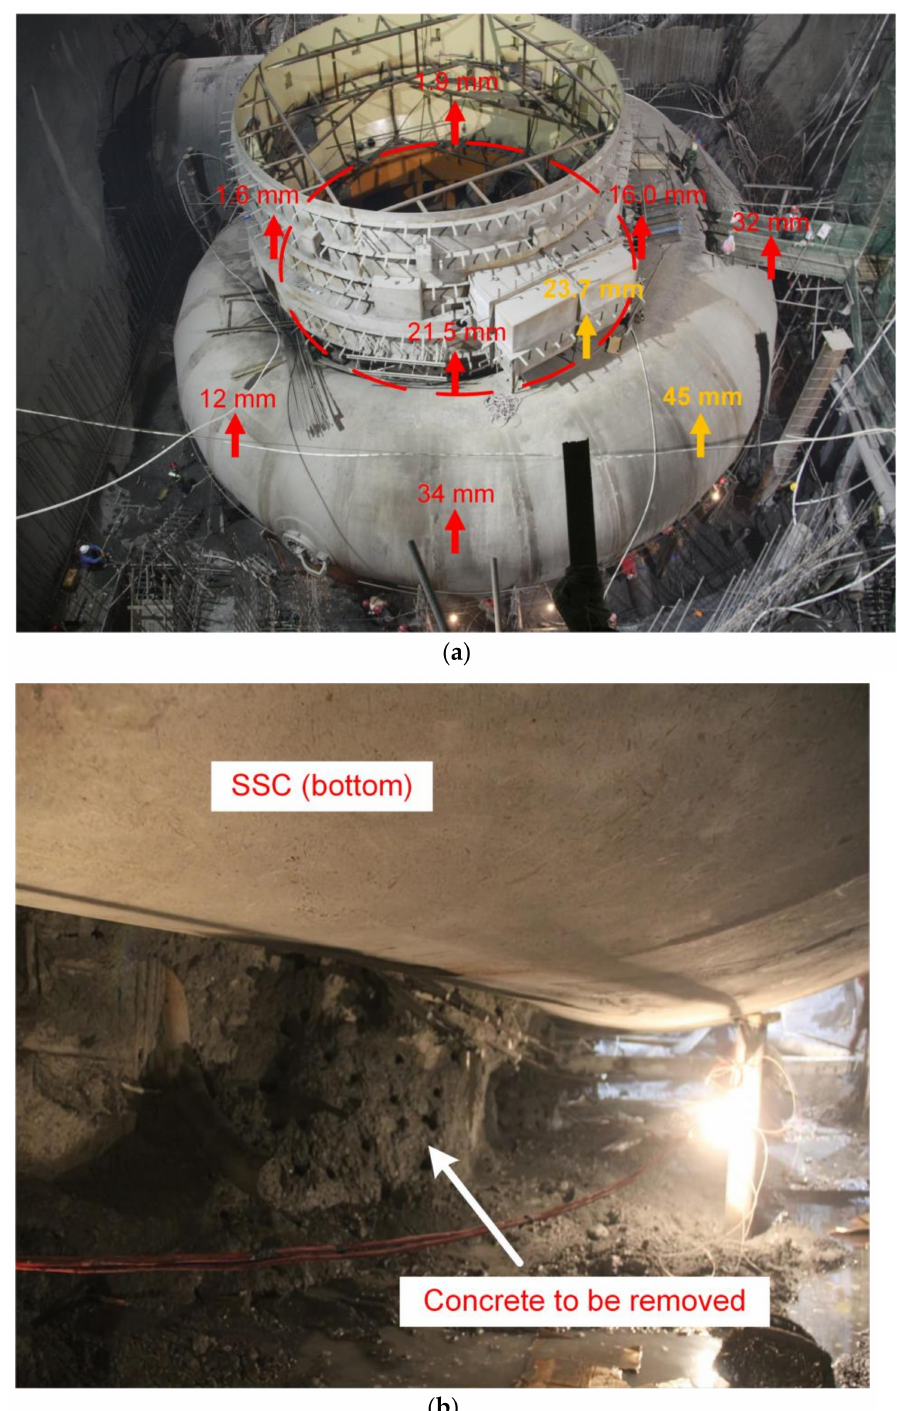
Figure 6. In-field scene of the SCS after the accident: ( a ) top view; ( b ) bottom